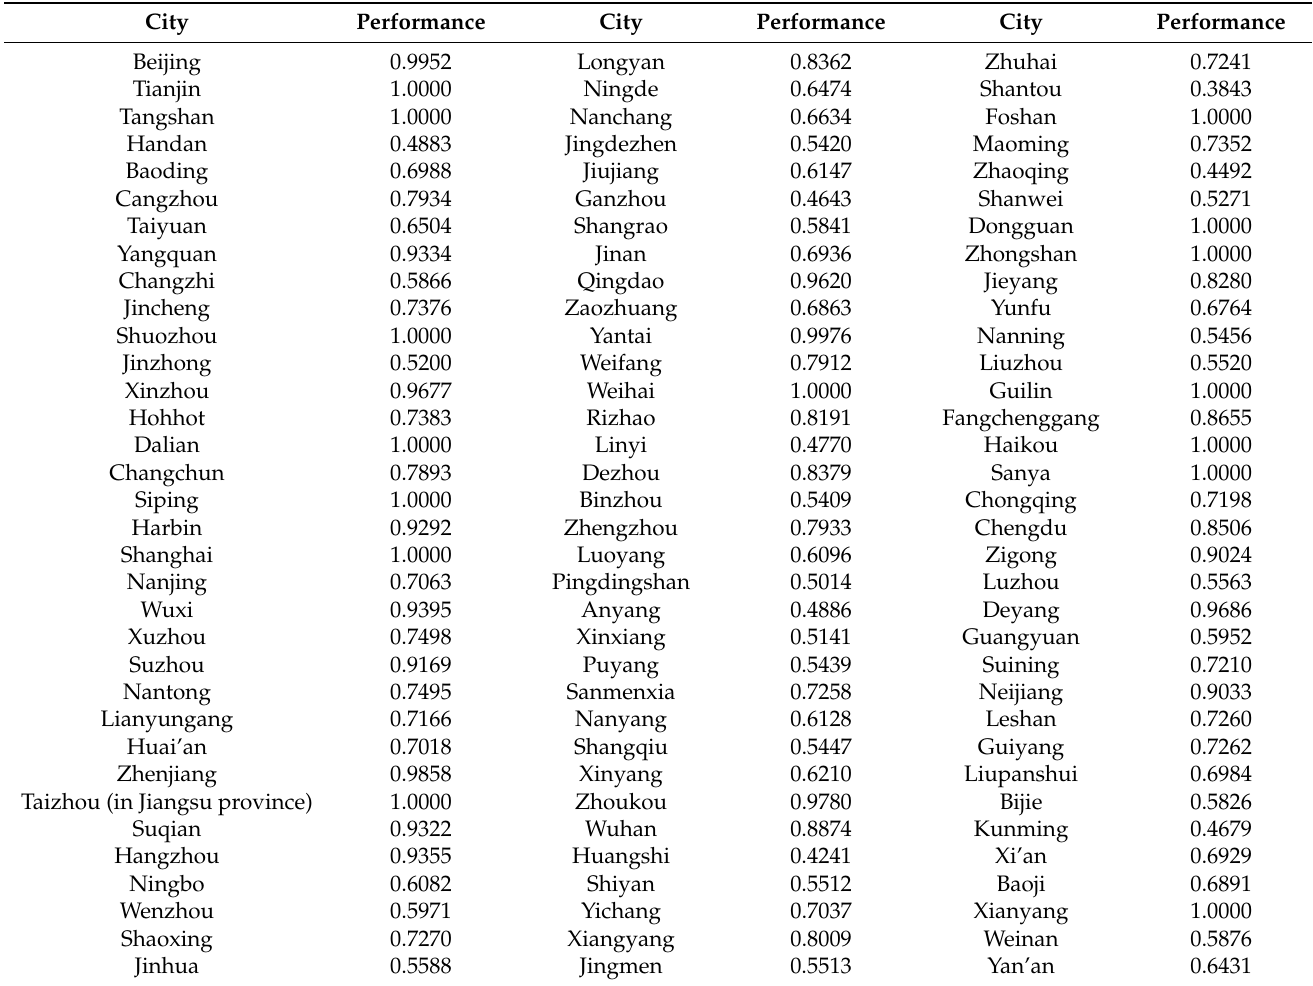
Table 2. The measurement results of energy performance of prefecture level cities in China in the economic